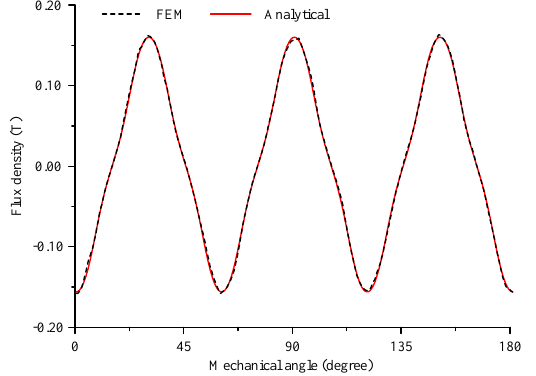
Figure 5. Flux density calculated by FEM and analytical model through the coils at the radius of 19 mm.